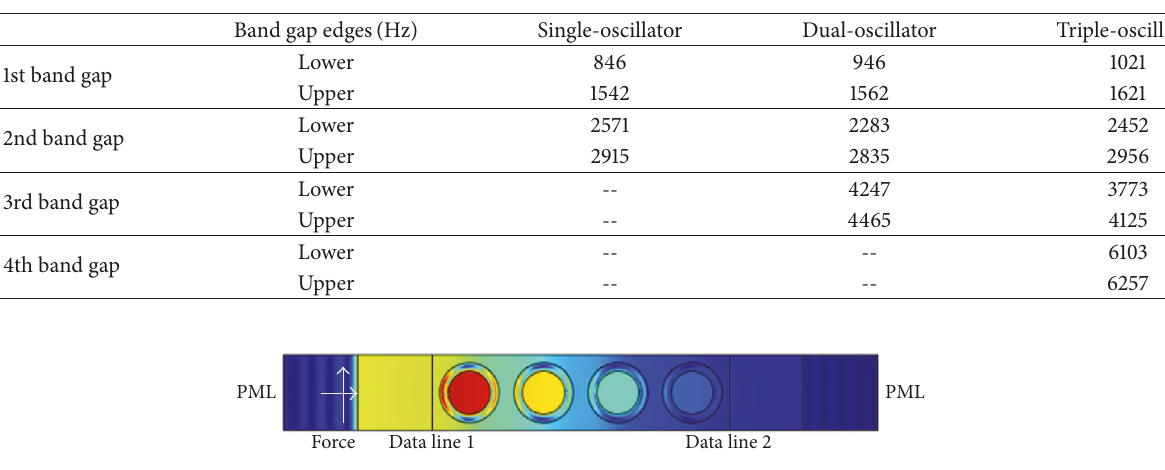
Figure 8: Numerical model for transmission computation. The color represents the